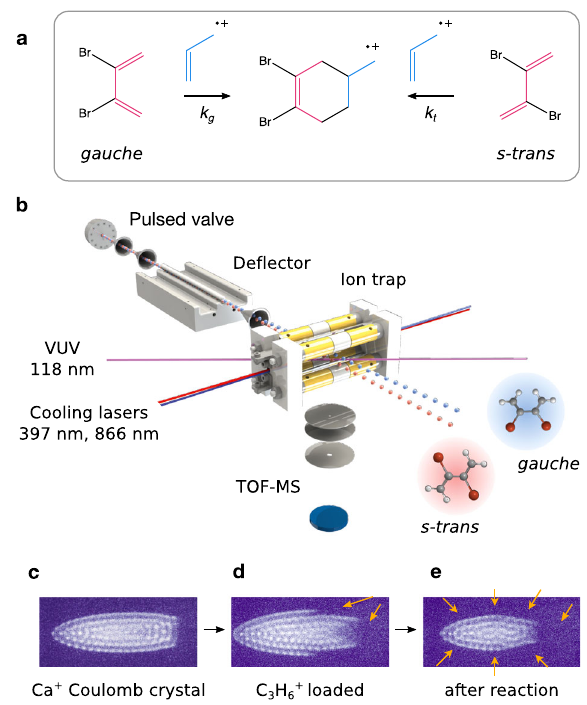
Fig. 1 Overview of the experiment. a Scheme of the polar cycloaddition reaction between the gauche and s-trans conformers of 2,3- dibromobutadiene (DBB) with propene ions exhibiting reaction rate constants k g and k t , respectively. The red and blue colours indicate the dienophile and the diene moieties, respectively. b Schematic of the experimental setup. The two conformers of DBB were separated by electrostatic de fl ection of a molecular beam and directed at an ion trap containing sympathetically cooled propene ions. Reaction products were measured by ion extraction into a time-of- fl ight mass spectrometer (TOF- MS). c – e Fluorescence images showing slices through laser-cooled Ca + Coulomb crystals at different stages of the experiment: c shows the initial, pure Ca + crystal, d shows an image after loading propene ions by vacuum- ultraviolet (VUV) photoionisation of propene and e is a typical image obtained after the reaction with DBB. Arrows indicate regions where ions heavier than Ca + accumulate in the